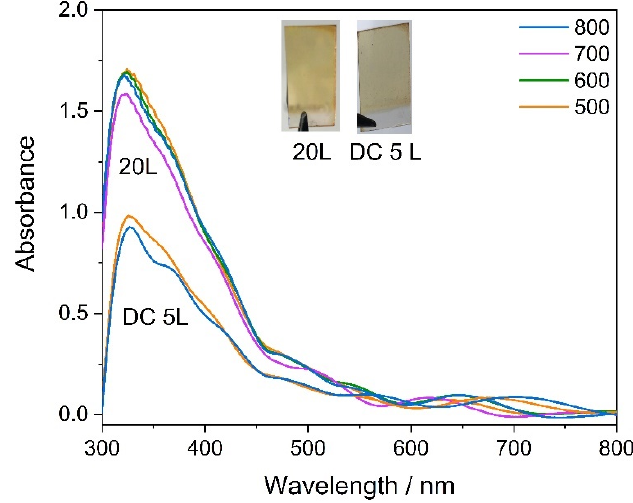
Figure 3. Absorption spectra of the 20L and DC_5L films series annealed at different temperatures (in Celsius).